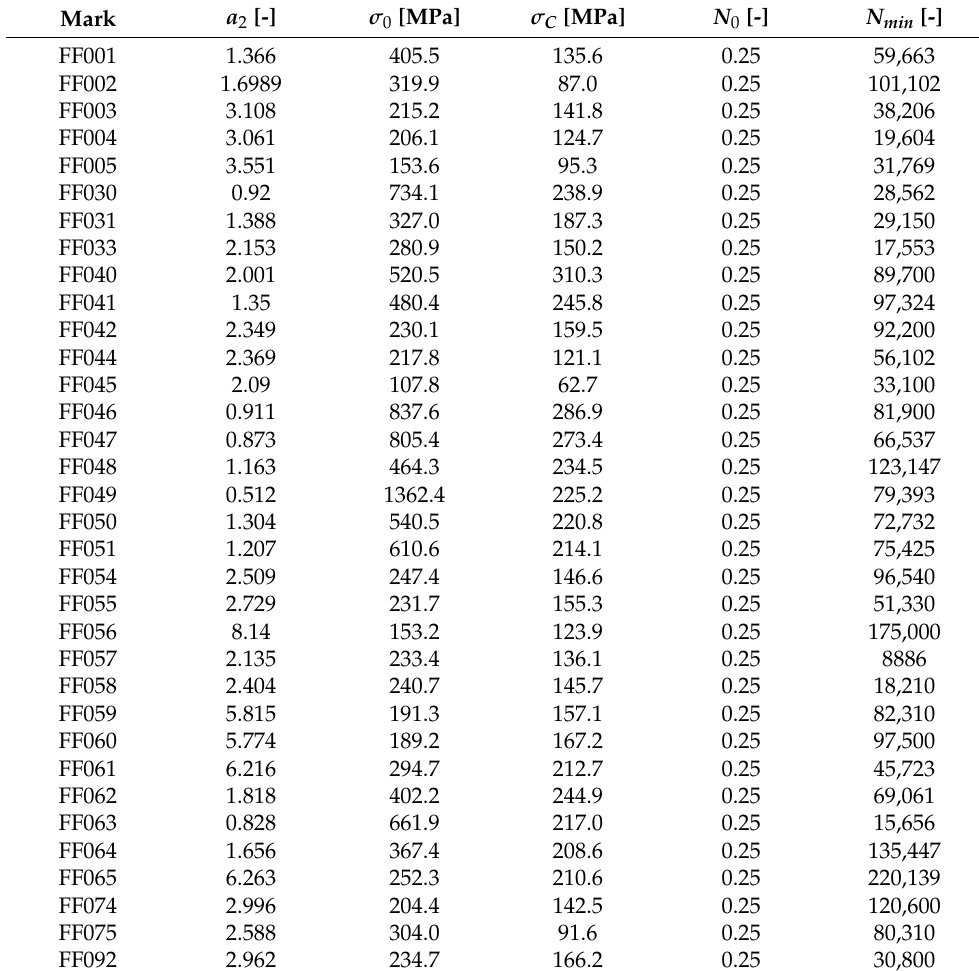
Figure 7. Comparison of the coefficient of determination R 2 for 3 evaluated regression formulas and individual load cases. Table 5. Parameters of the FF approximations (Equation (4)) for each load case, including also the lowest measured experimental lifetime N min , which together with the run-out level at 10,000,000 cycles define the complete interpolation region of each regression